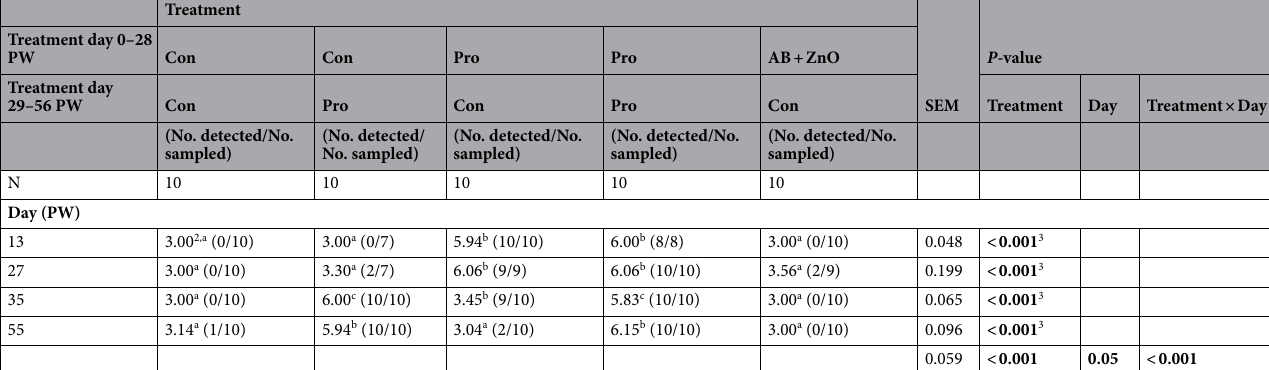
An effect on overall granulocyte counts was also observed; whereby the AB + ZnO treatment group had a lower count than the Con/Pro treatment group ( P < 0.01). The AB + ZnO treatment group also had a lower percentage of granulocytes than the Pro/Con treatment group at D28 PW ( P < 0.05) and overall ( P < 0.01), but granulocyte percentage was not different for any treatment group compared with Con/Con. As regards red blood cell-related parameters, the AB + ZnO treatment group had lower red cell distribution width than the Pro/Pro treatment group on D28 PW ( P < 0.01) and overall ( P < 0.05) but this parameter was not affected by any treatment group compared with Con/Con. A treatment × day interaction was observed for the mean corpuscular volume ( P < 0.01), which decreased with increasing age. In addition, there was an effect of treatment on mean corpus- cular volume at D28 PW (P < 0.001) and overall ( P < 0.05). On D28 PW the AB + ZnO treatment group had a lower mean corpuscular volume than the Con/Con ( P < 0.01) and Con/Pro ( P < 0.001) treatment groups, while overall the AB + ZnO treatment group had a lower mean corpuscular volume than the Con/Pro treatment group only ( P < 0.05). Overall, the Con/Pro and Pro/Con treatment groups had lower platelet counts than the Pro/Pro treatment group ( P < 0.05), but this parameter was not affected by any treatment group compared with Con/Con.